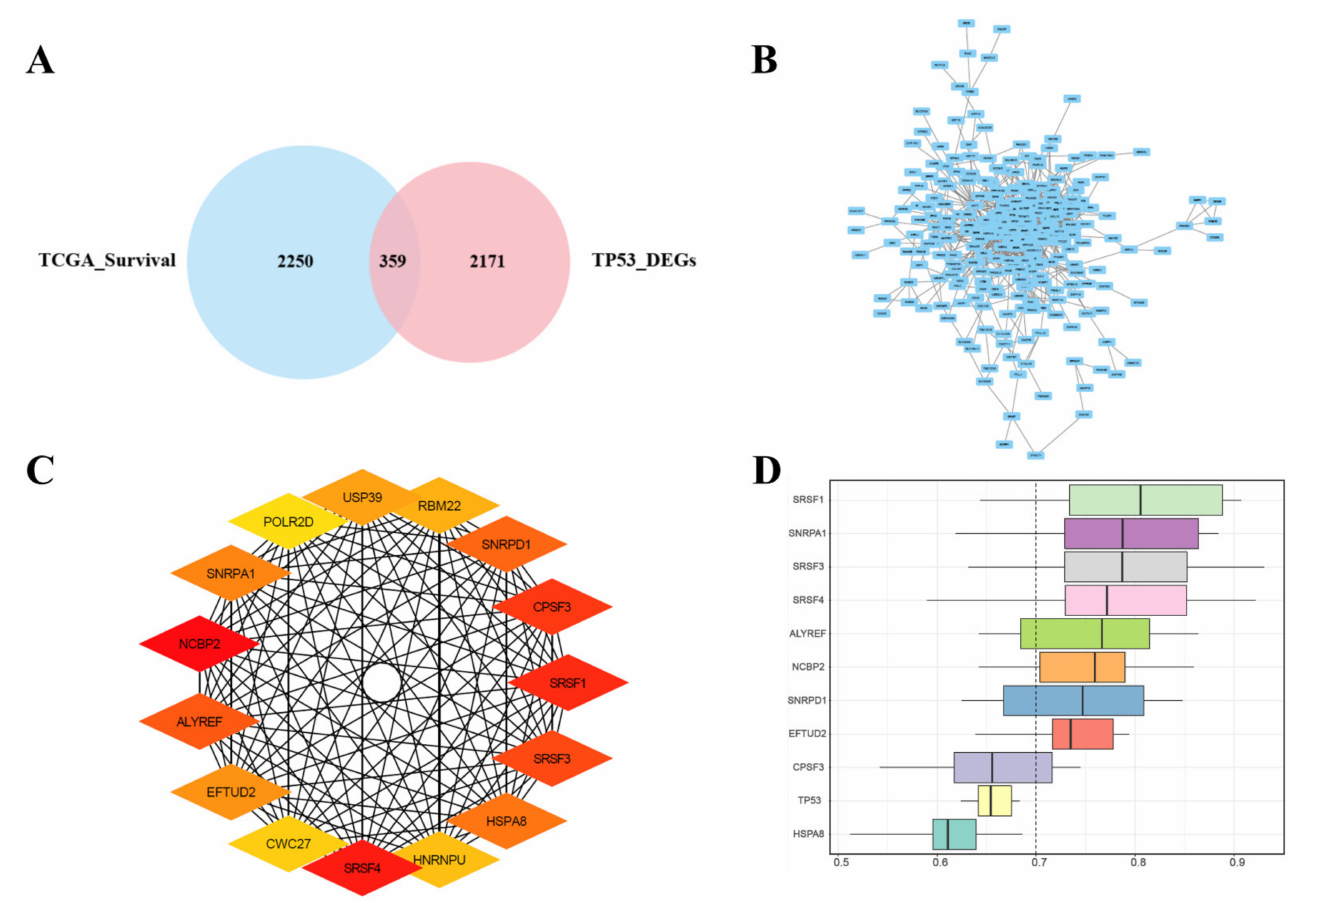
Figure 3. Joint screening of DEGs, Protein–protein interaction (PPI), hub DEGs, and functional similarity analysis of DEGs. ( A ) Venn diagram of DEGs between high- and low-TMB groups and the prognosis-related genes with p value less than 0.05 in Cox univariate analysis obtained from TCGA. Middle part represents overlap of two groups of data. ( B ) Gene interaction network of 359 prognosis- related DEGs visualized with PPI network. ( C ) Interaction network of 15 DEGs scored by maximum correlation coefficient; the darker the color, the higher the MCC algorithm score. ( D ) Functional similarities of 11 hub genes—dashed line represents cut-off value of similarity. DEGs: Differentially Expressed Genes; TCGA: The Cancer Genome Atlas; MCC: Matthews correlation